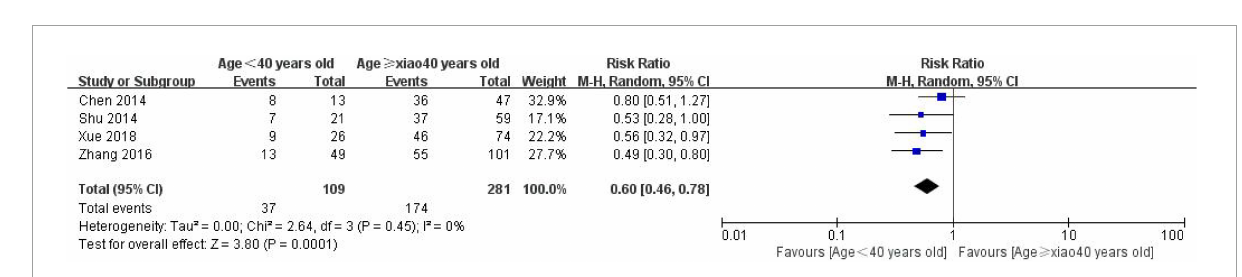
FIGURE5 Forest map related to CD24 expression and